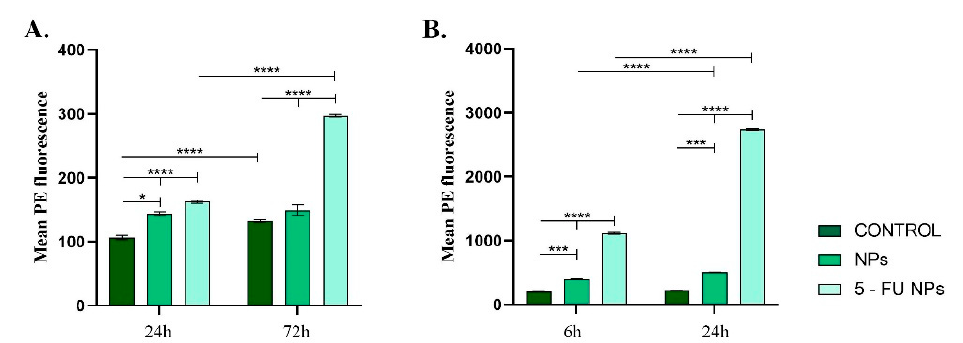
Figure 7. TNF– α expression profile detected in ( A ) . HT–29 cell cultures exposed for 24 h and 72 h to 12 mg/mL SF/PEG NPs ± 5-FU and ( B ). whole blood exposed for 6 h and 24 h to 12 mg/mL SF/PEG NPs ± 5-FU (* p ≤ 0.05; *** p ≤ 0.001; **** p ≤